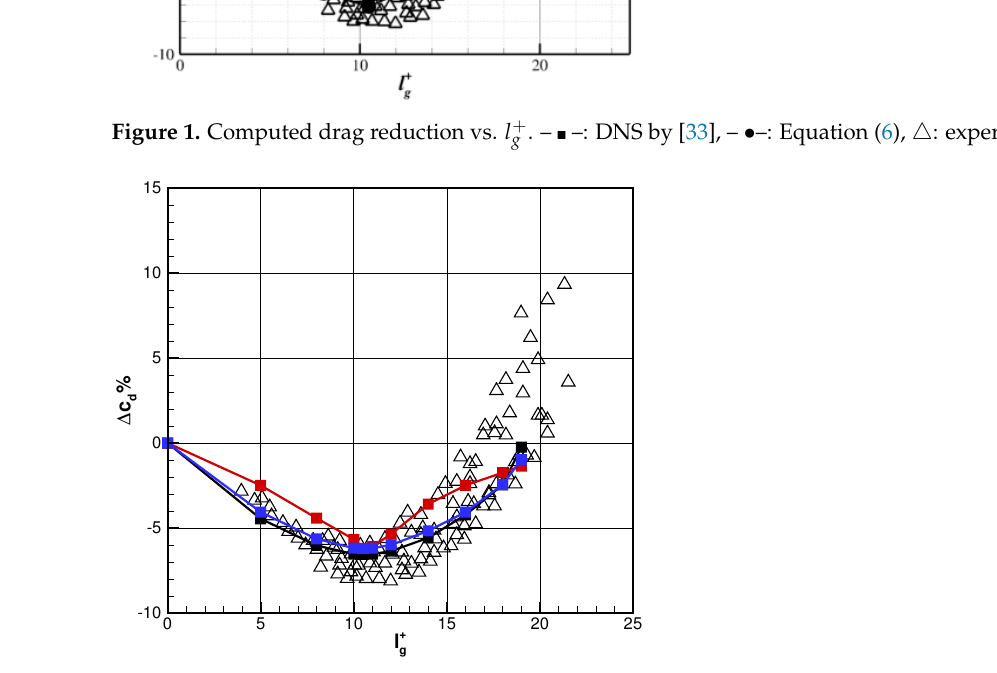
Figure 2. Computed drag reduction vs. l + g . Red: Equation from [22], blue: Equation (8), black: Equation (9) (cid:52) : experiment